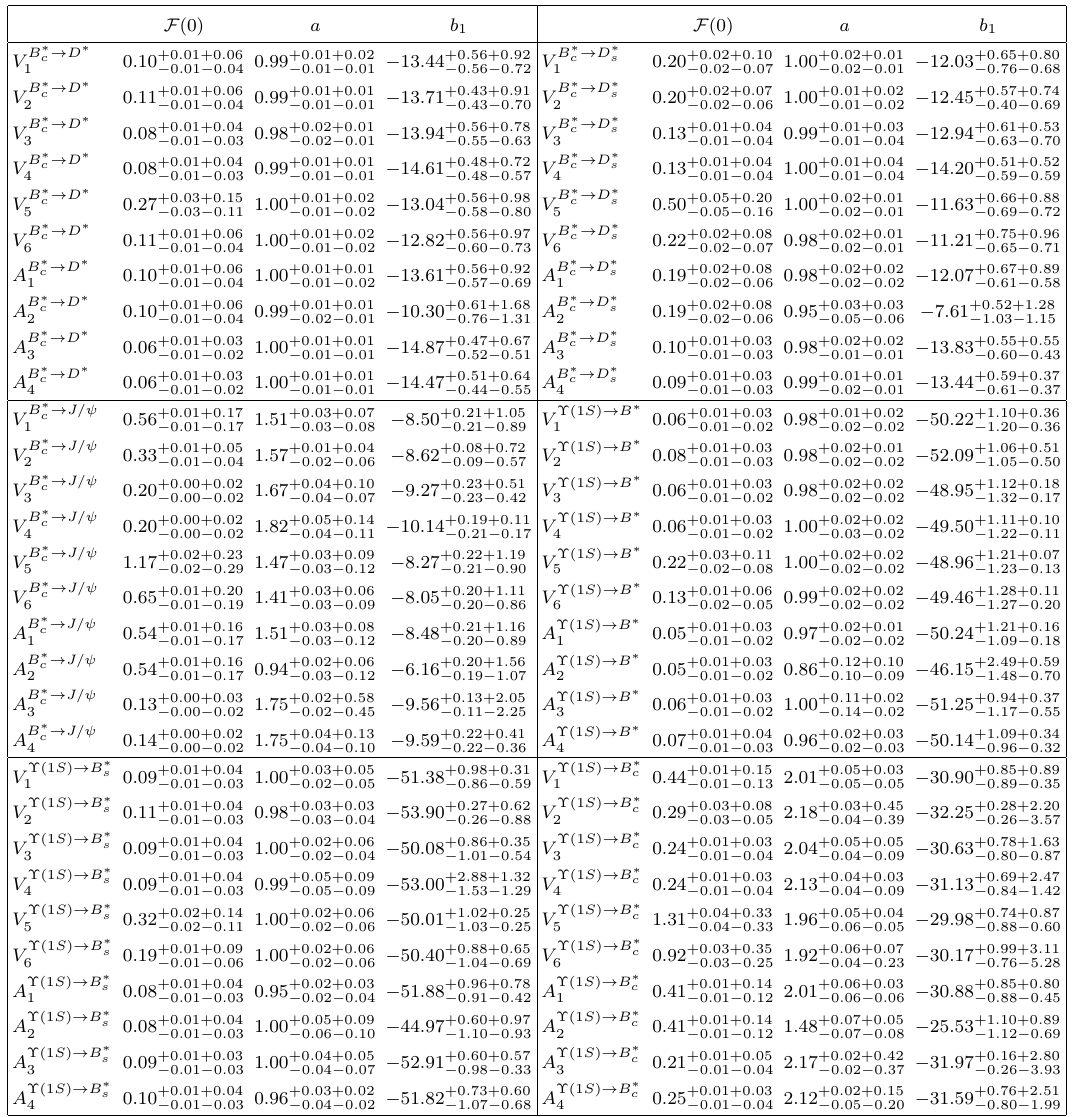
! ( D (cid:3) ; D (cid:3) ; J= (cid:9)) and (cid:7)(1 S ) ! c s